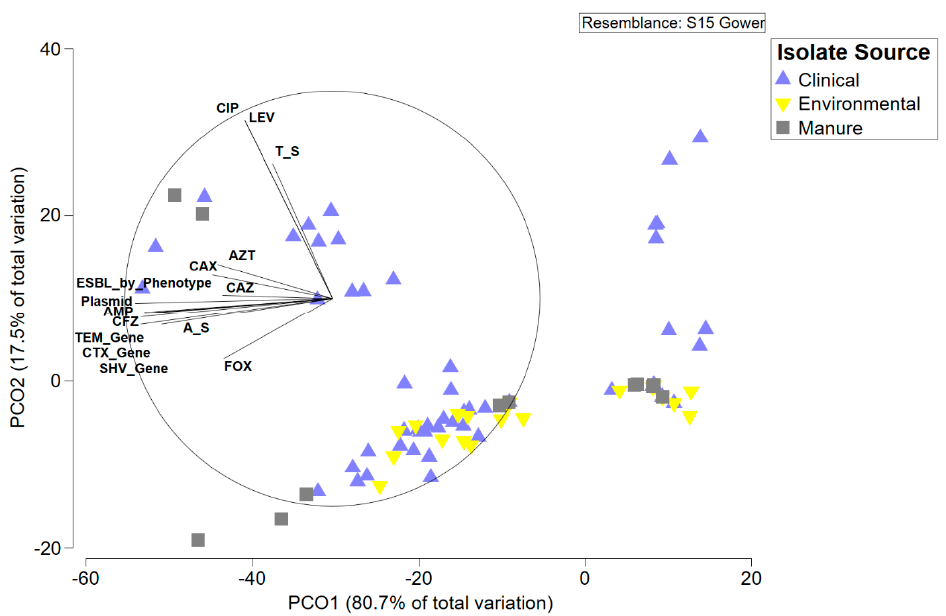
Figure 5. Principal coordinate analysis of all measured traits of E. coli isolates in this study based on Gower distance. Measured traits with a correlation strength of >0.5 are displayed on the plot. Gower distance. Measured traits with a correlation strength of > 0.5 are displayed on the